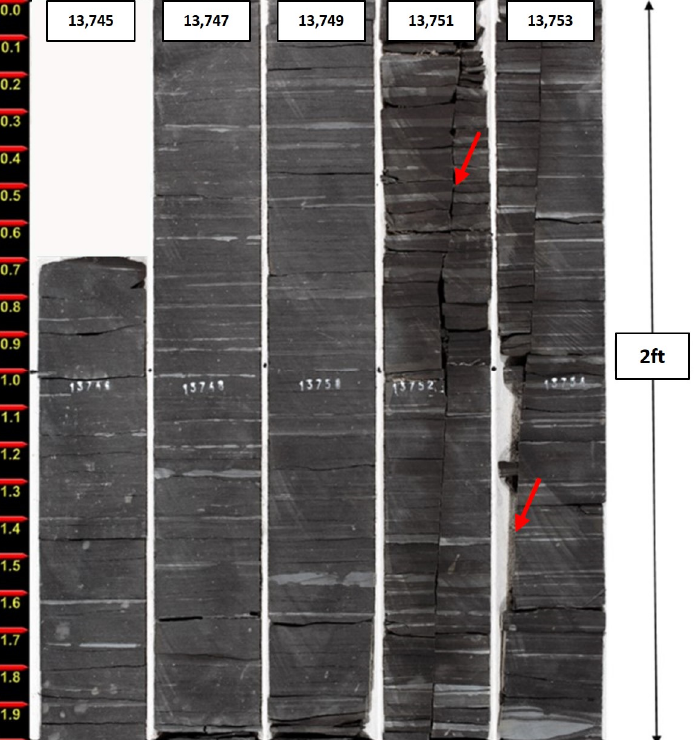
Figure 6. Example of a near-vertical extension fracture in a slab core retrieved from the East Feliciana well. The fracture extends from the bottom of the third row through the next two rows and out of the core, having a height of at least four feet. No vertical fracture terminations are identified, as the fracture cuts indiscriminately across the shale layers. Calcite mineralization is observed on the walls of the fracture. Red arrows indicate the location of the fracture.